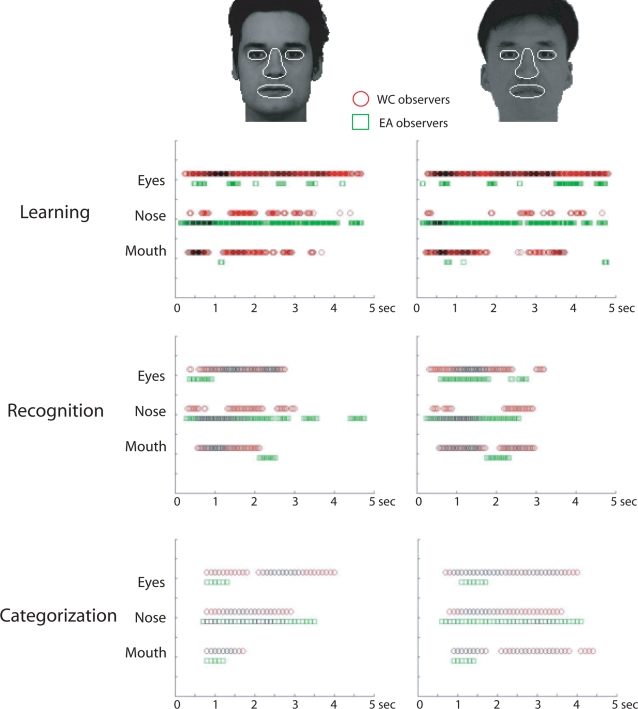
Time course of significant fixations on facial features (eyes, nose and mouth) during face learning, recognition and categorization by race, for WC (red square - top rows) and EA (green circle - bottom rows) observers (Zcrit>4.64; p<.05).The significant facial feature fixations are weighted by the surface area they covered within the region of interest; with darker outlines relating to wider regions.